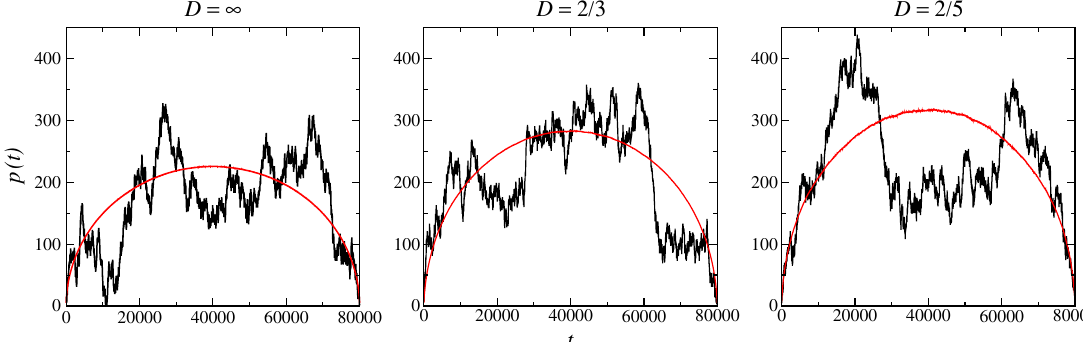
FIG. 4. We show three typical Bessel excursions for D ¼ ∞ , 2 = 3 , 2 = 5 (left to right panel) and the mean (red curve). The random excursions are constrained Langevin paths, with a − 1 =p force, that do not cross the origin in the observation time t and that start and end on ϵ → 0 . For simulations, we use the regularized force field, which only alters the dynamics when p ≃ 1 and is negligible in the long- time limit (see Appendix D). When D → ∞ , we get a Brownian excursion. We see that as D is decreased, the excursions are further pushed from the origin p ¼ 0 since small D effectively implies large attractive forces; hence, to avoid the zero crossing, the particles must drift further away from the origin. Thus, the attractive force repels particles, which at first might sound counterintuitive and might seem to be an unexplored property of